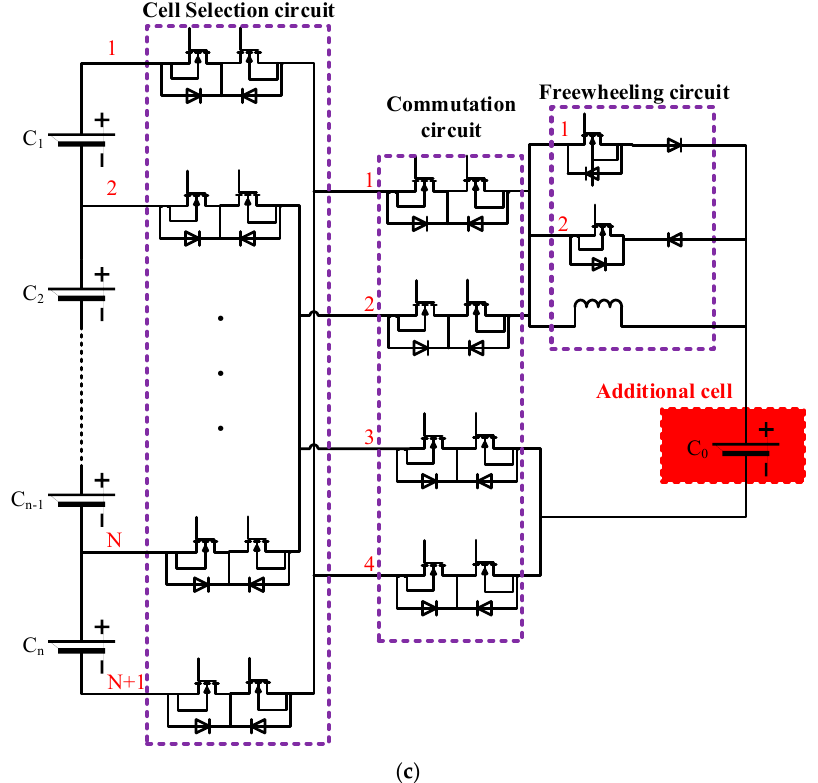
Figure 1. Configuration and circuit of composite equalization. ( a ) Configuration; ( b ) passive equalization circuit; and ( c ) active equalization circuit.